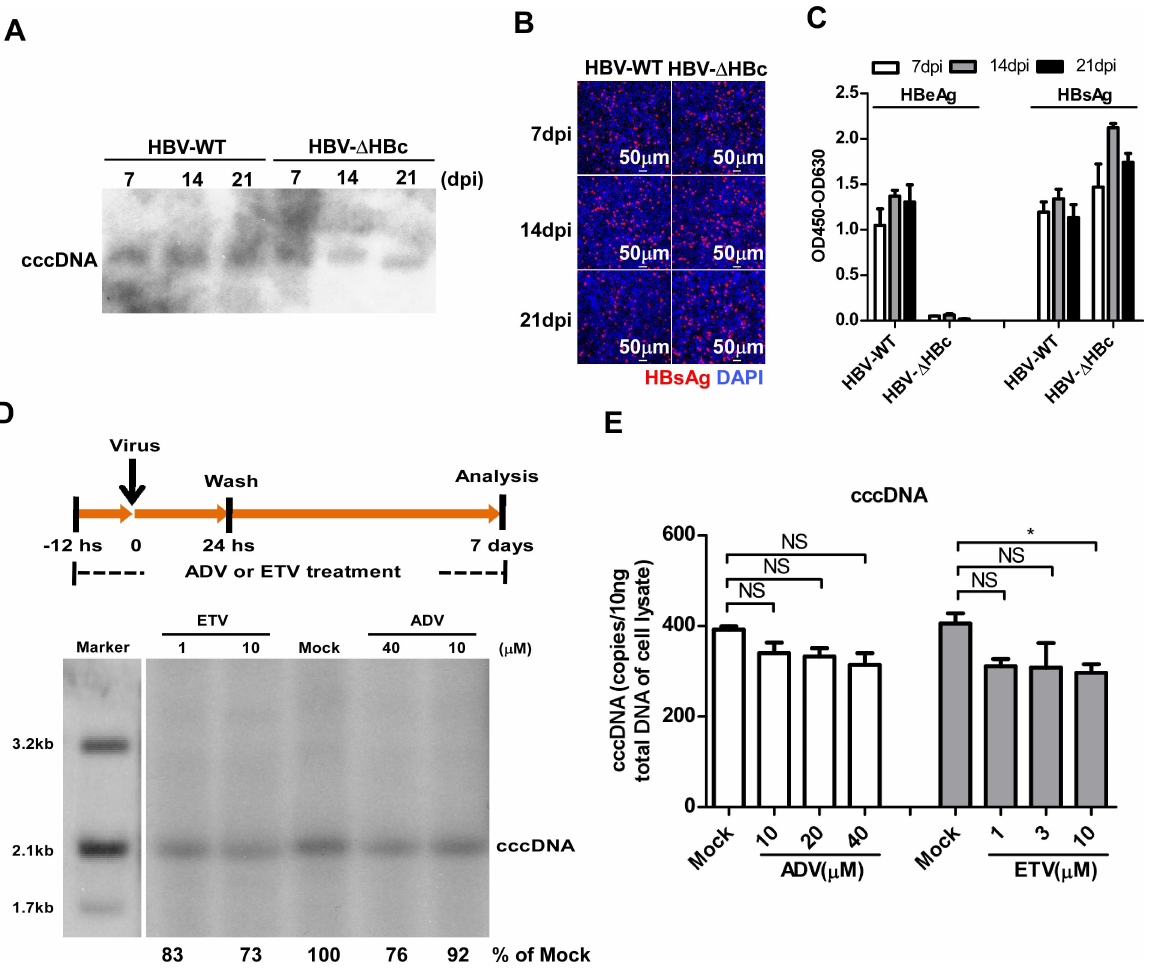
Fig 2. HBV DNA polymerase activity is dispensable for cccDNAbiosynthesis in a de novo infection. (A-C) HepG2-NTCP cells were infected with a multiplicity of 100 genomeequivalents(mge) of wild-type or HBcAg-deficient (HBV- Δ HBc) virus. On the indicatedtime points after infection, HBV cccDNA was determinedby Southern blot analysis (A). Intracellular HBsAg was stained with mcAb 17B9 (red) and nuclei were stained with DAPI (blue). Images were taken with a Nikon A1-R confocal microscopy. Scale bars, 50 μ m (B). Secreted HBeAg and HBsAg were measured by ELISA (C). Data are representatives of three independent experiments. (D-E) HepG2-NTCP cells were mock-treated or treated with the indicatedconcentrations of adefovir (ADV) or entecavir (ETV) from 12 h before HBV- Δ HBc infection to 7 dpi as depicted in the top panel (D). HBV cccDNA in the infected cells were detected by Southern blot analysis(D). The intensity of HBV cccDNA bands were determinedby Image J and the relative amounts of cccDNA were expressed as the percentageof that in the mock-treated control cells. HBV cccDNA was also quantifiedby a qPCR assay (E). Data are representatives of three independent experiments. Data were analyzedby an unpairedtwo-tailed t test. NS: non-significant; * p <